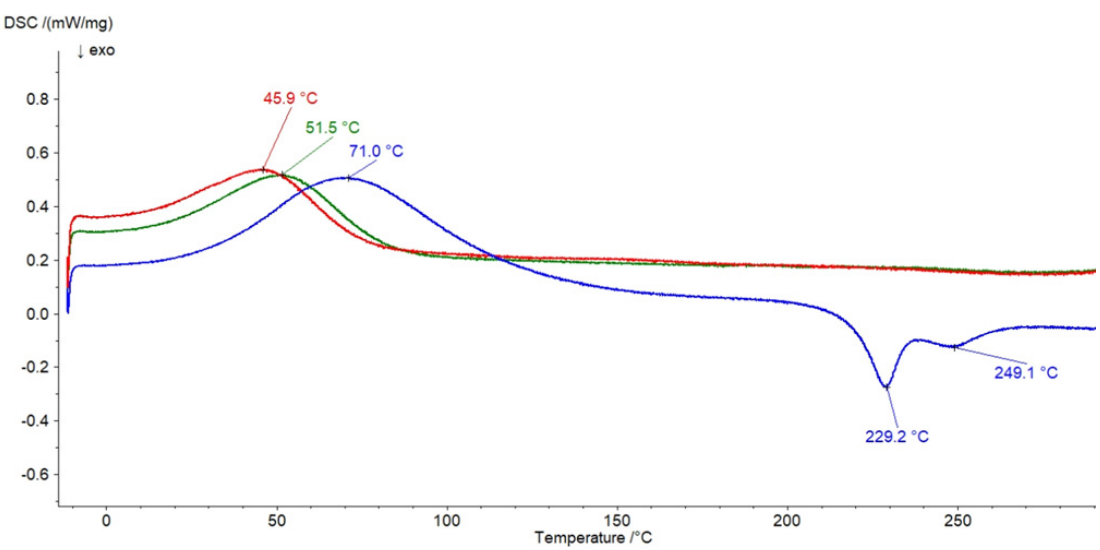
Figure 9. The thermograms of formulation F1 (red), formulation F4 (green), and physical mixture of HA and MC (blue).